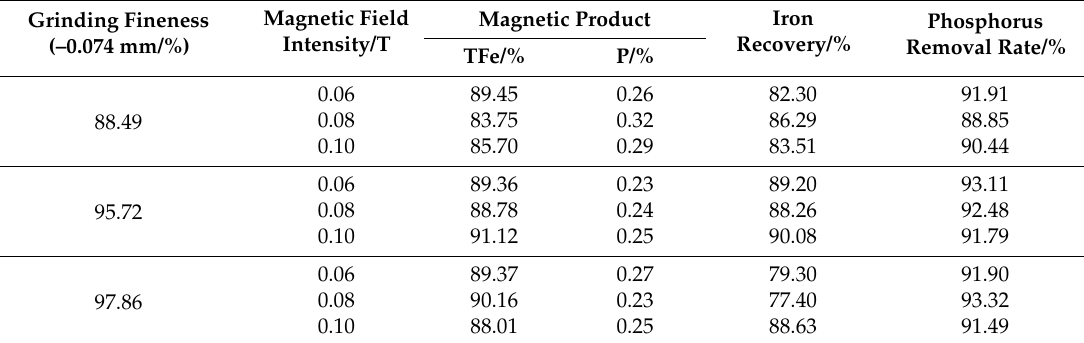
Table 7. Effects of the grinding-separation process on upgrading of iron and phosphorus removal. Grinding